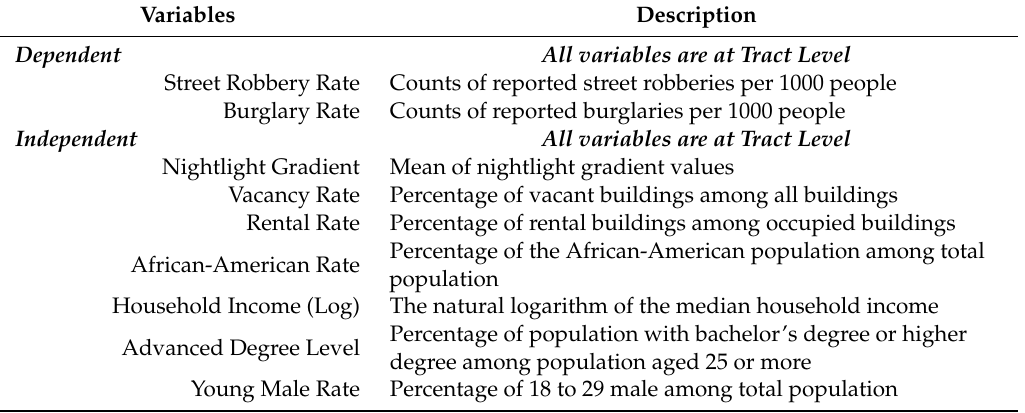
Table 3. All variables in negative binomial regression models (N = 114).